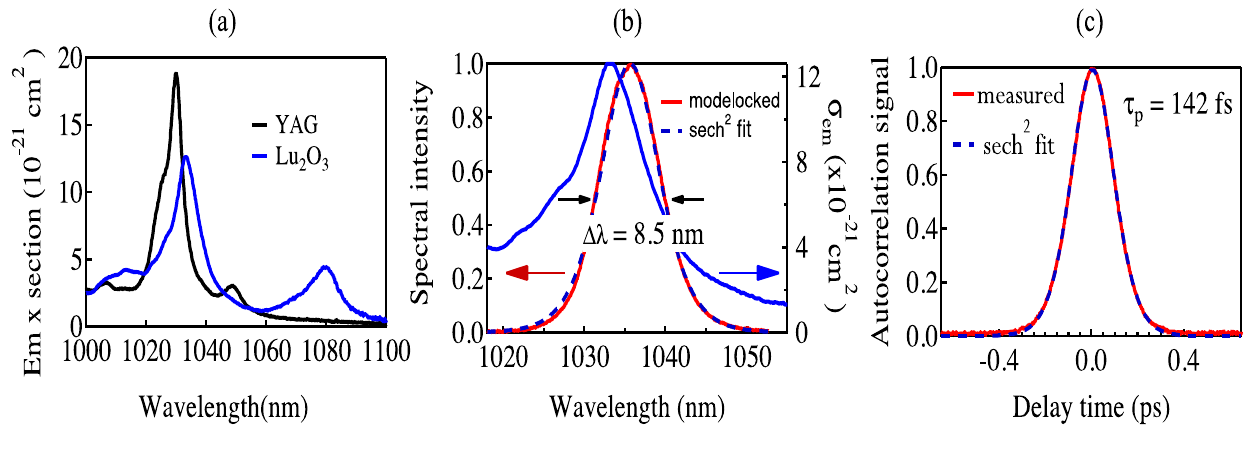
Figure 17. ( a ) Emission spectrum of Yb:LuO and Yb:YAG. ( b ) Spectrum of the modelocked laser delivering 142 fs, showing a 8.5 nm-wide (FWHM) modelocked